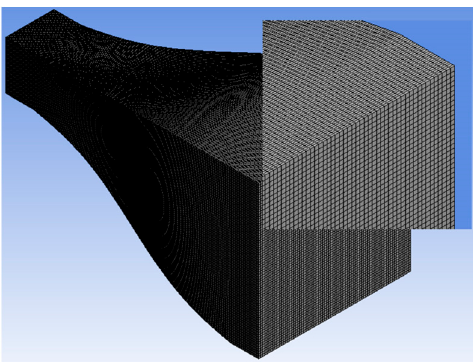
Figure 3. A view of example mesh setting.